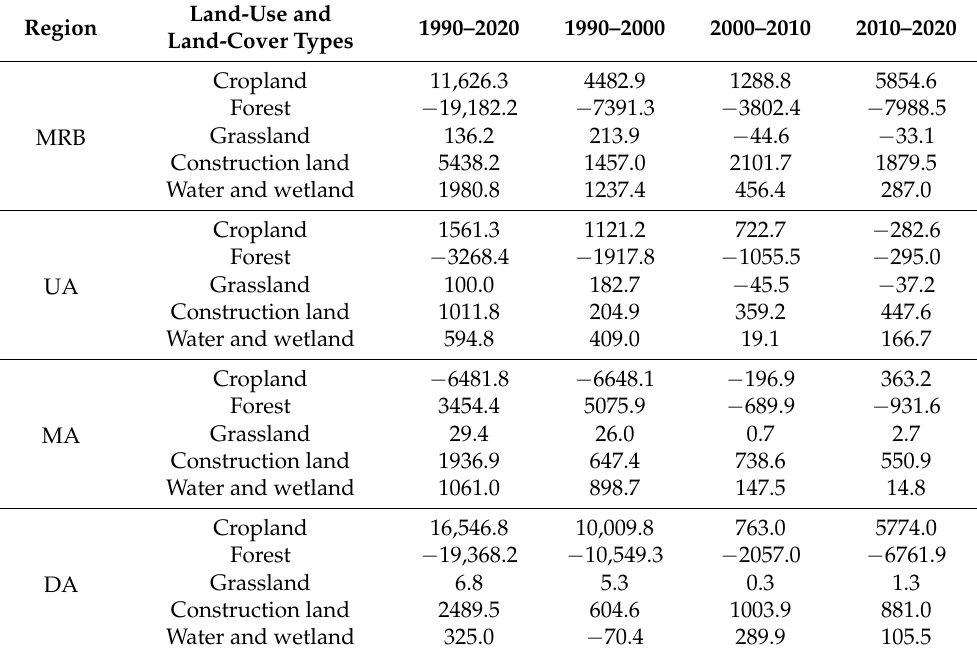
Table 1. Area change (km 2 ) of land use in the Mekong River Basin (MRB) from 1990 to 2020. Land-Use Region